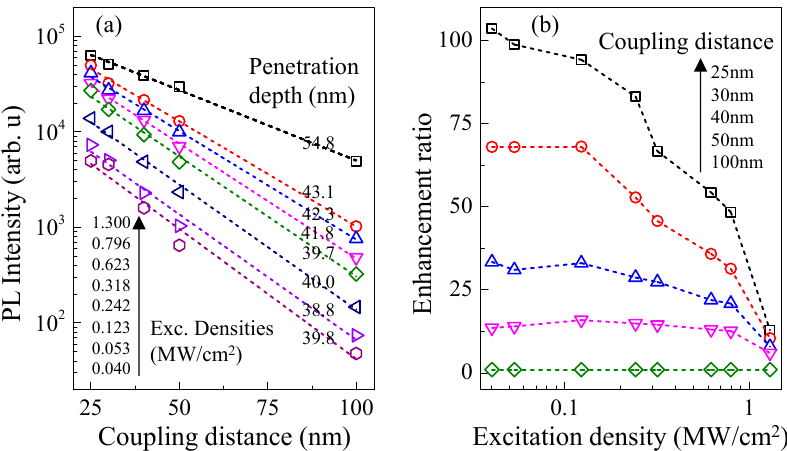
Figure 6. ( a ) The excitation power dependent near ‐ field PL vs. position of Ag NPs sample 4 ( b ) The corresponding enhancement vs. excitation power of Ag NPS sample 4 at different coupling distances.